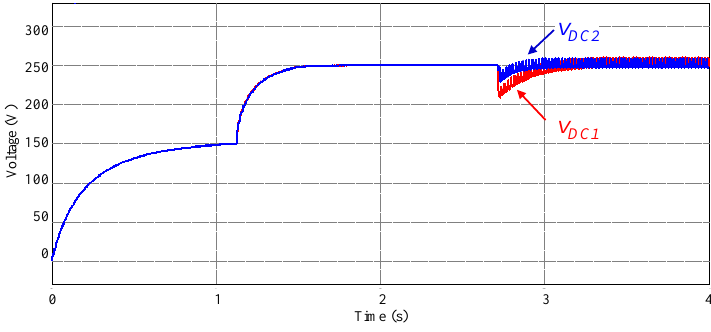
Figure 9. Evolution of the DC-link voltages ( v DC 1 and v DC 2 ) during the start-up of the SAPF.